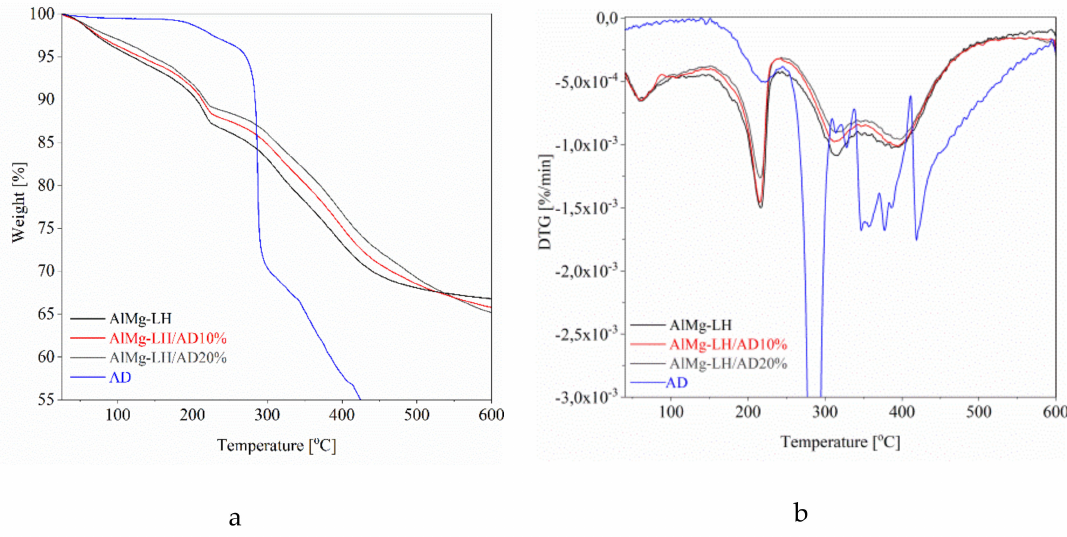
Figure 9. Thermogravimetric analysisTGA ( a ) and difference thermogravimetric analysis DTG( b ) for hybrid pigments with 10% and 20% dye